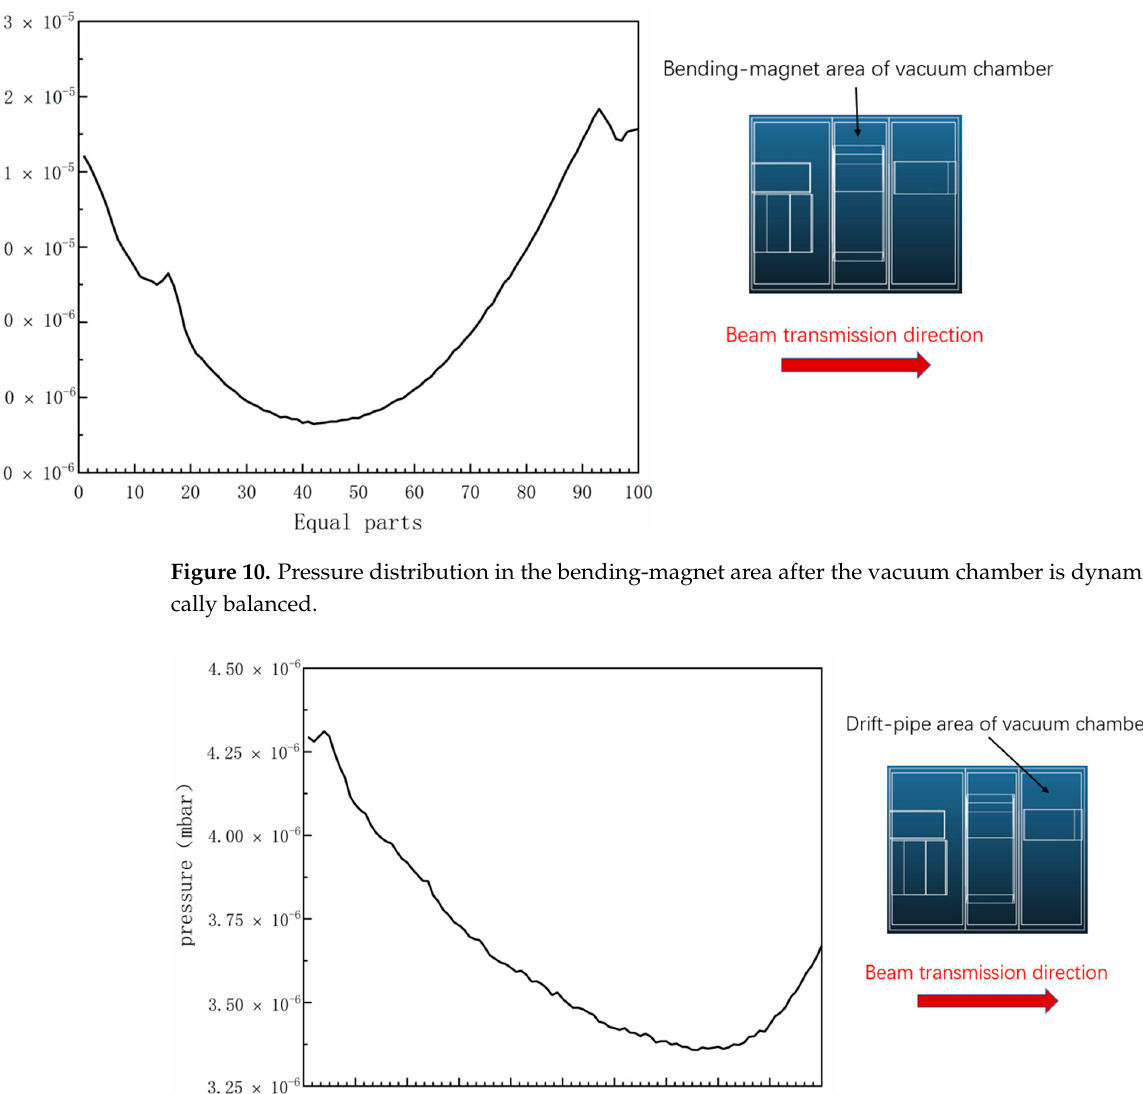
Figure 9. Pressure distribution in the neutralized area after the vacuum chamber is dynamically balanced.